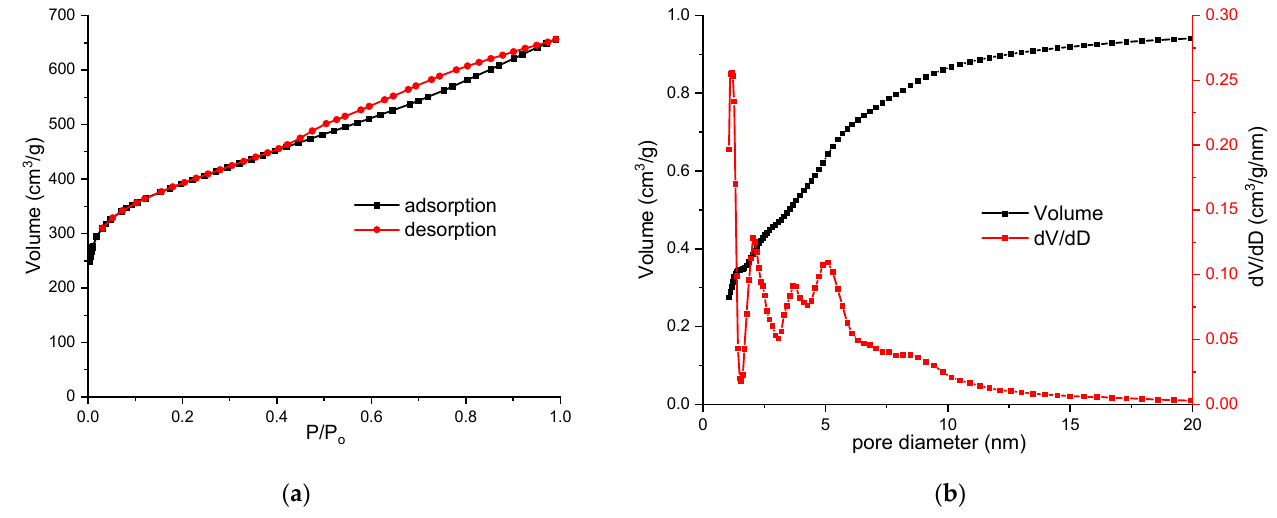
Figure 1. Nitrogen adsorption–desorption isotherms ( a ) and pore volume distribution curves ( b ) for sample AC-A. Table 1. Structural parameters and specific surface area of the AC-A